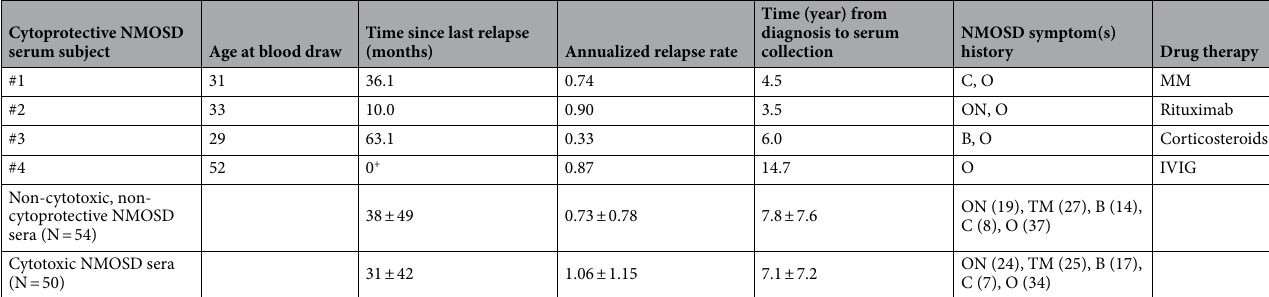
Table 1. Clinical information on NMOSD subjects with cytoprotective sera. Mean ± S.D., + Blood draw during active relapse. B brainstem symptoms, C cerebral symptom, O other symptom, ON optic neuritis, TM transverse myelitis, MM mycophenolate mofetil, IVIG intravenous immunoglobulin.